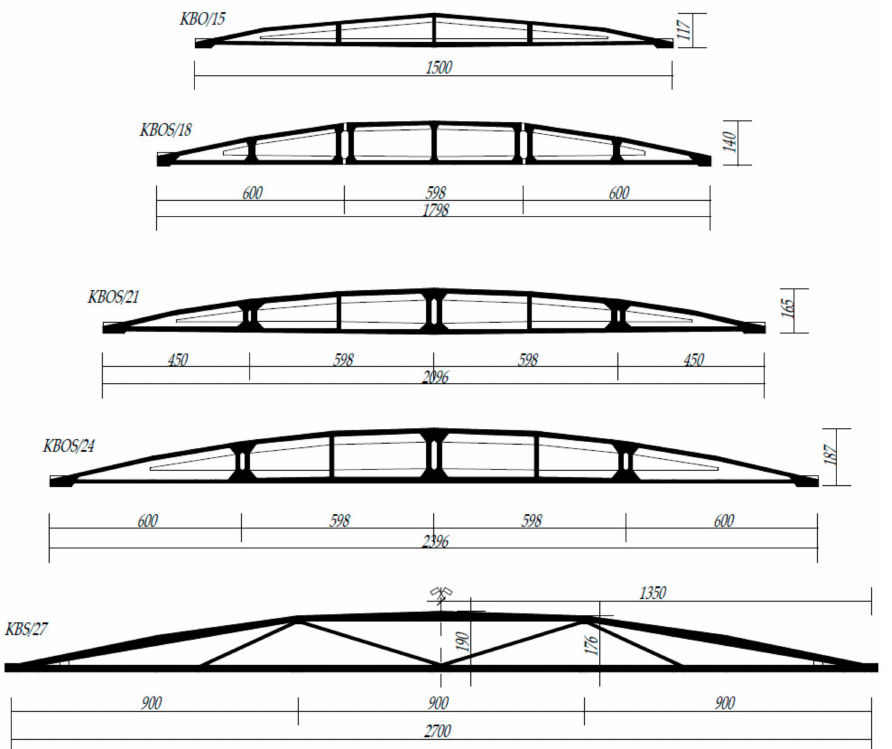
Figure 1. Form and dimensions of example cable post-tensioned concrete